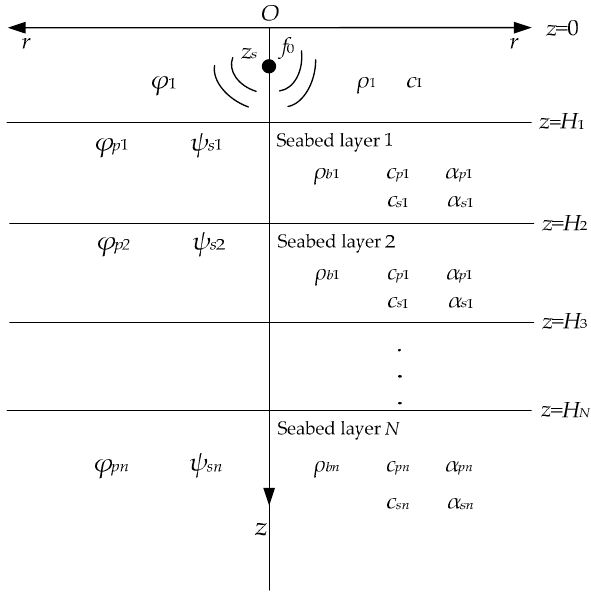
Figure 2. A layered shallow sea waveguide model.